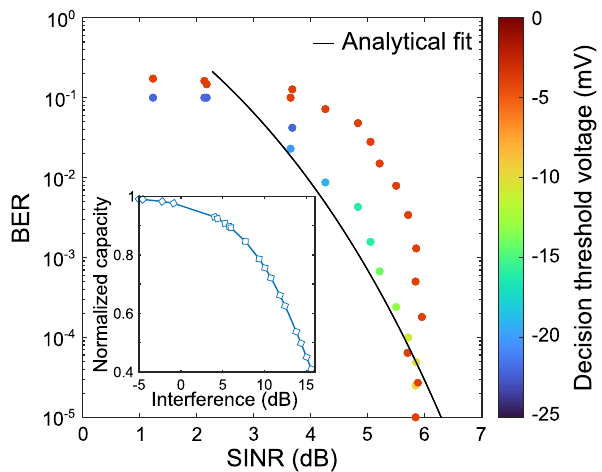
Fig. 4 Effect of the interference and decision threshold. Experimental measurement of the bit-error rate (BER) as a function of the signal-to- interference-plus-noise ratio (SINR). The color of the dots corresponds to the value of the threshold voltage Bob uses to distinguish a one from a zero. Here, the negative value of the threshold and of the data signal is a consequence of the use of low-noise ampli fi ers after the Schottky diode in our particular technical con fi guration. The red dots are for a fi xed value of the threshold initially optimized in the absence of Mallory. The results for the optimized threshold is in agreement with the general trend of the analytical expression for the error probability for noncoherent OOK system in the case of a decision point not taken at the half point (black curve, see “ Methods ” ). The inset shows the theoretical normalized channel capacity (calculated from measurement results of the SINR) as a function of the interference contribution (see “ Methods ” for